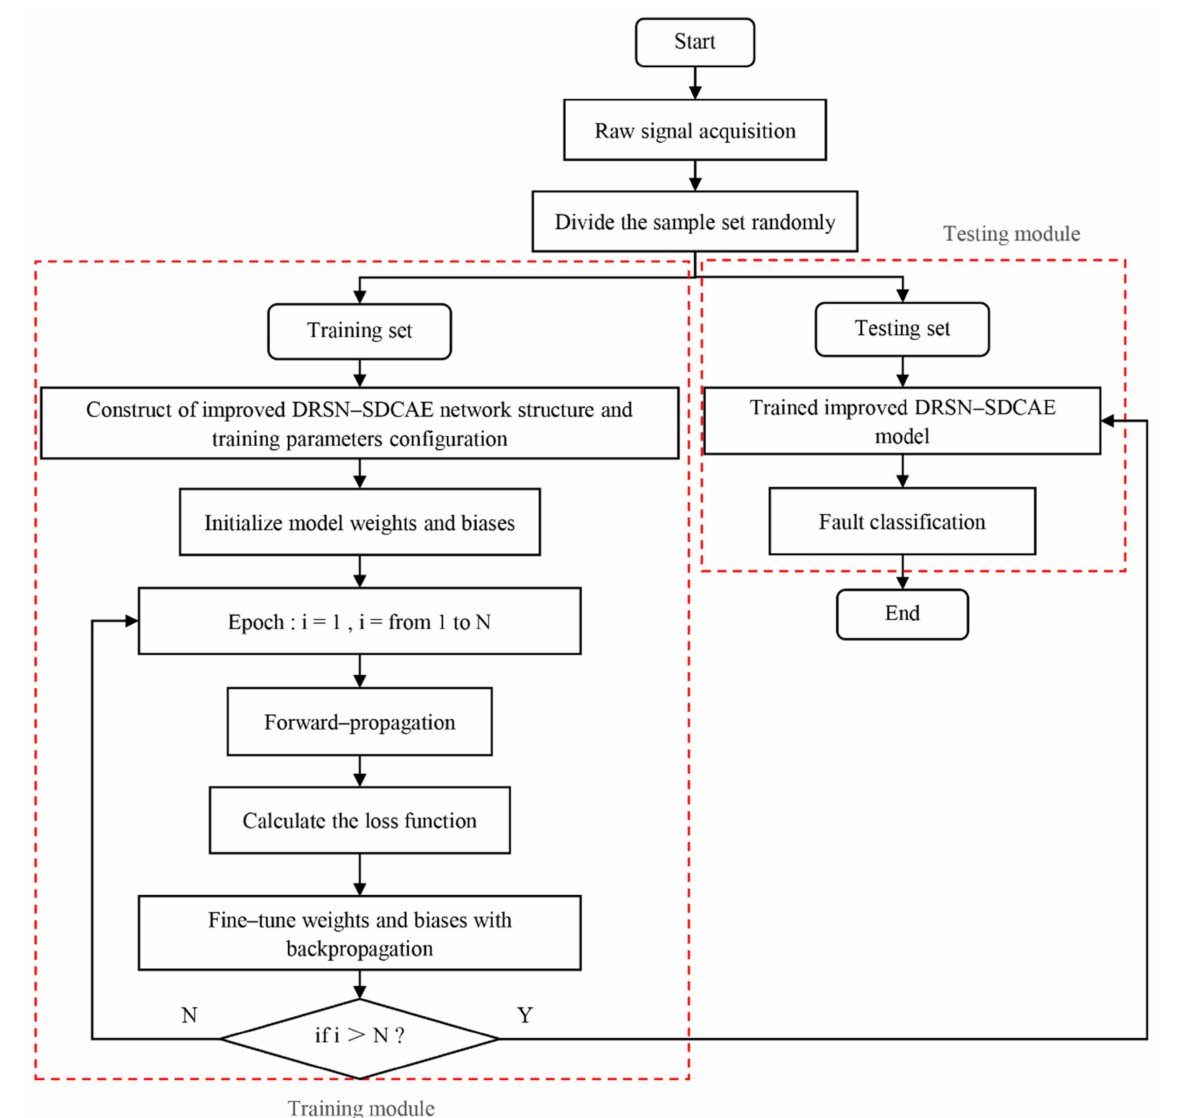
Figure 6. Flowchart framework of the improved DRSN–SDCAE fault diagnosis